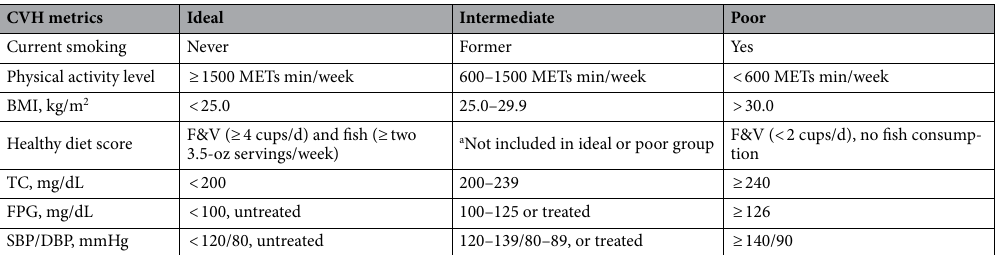
Table 1. The modified American Heart Association 2020 impact goals of ideal, intermediate, and poor CVH metrics. CVH metrics, cardiovascular health index; METs, metabolic equivalent tasks; BMI, body mass index; F&V, fruit and vegetable; TC, total cholesterol; FPG, fasting plasma glucose; SBP, systolic blood pressure; DBP, diastolic blood pressure. a F&V (≥ 4 cups/d) without fish, F&V(2–4 cups/d) and fish (≥ one 3.5-oz serving/ week), F&V (< 2 cups/d) and fish ((≥ one 3.5-oz serving/week), fish (≥ one 3.5-oz serving/week) without